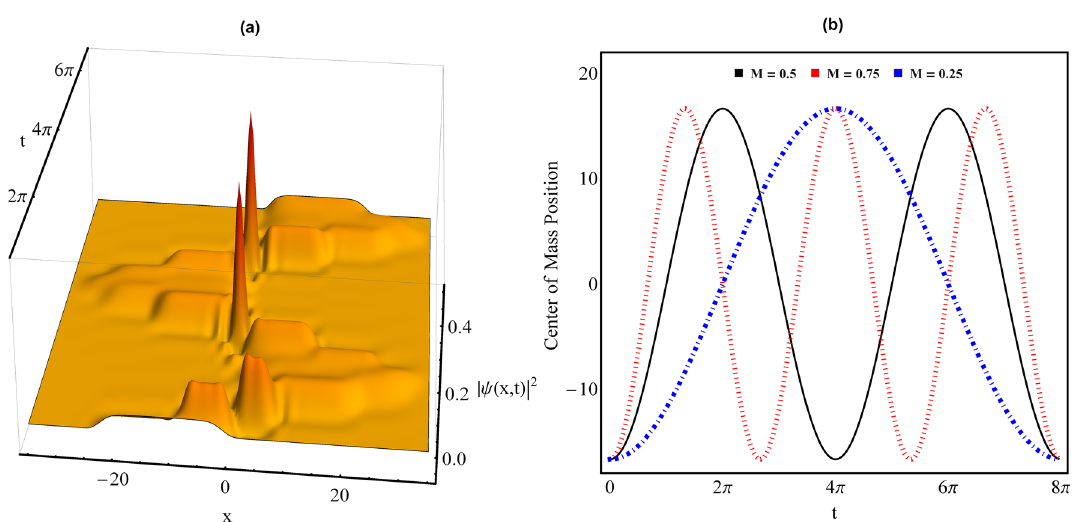
0.5 , = 25 , 1.5 , δ = = 0.75 ), and =